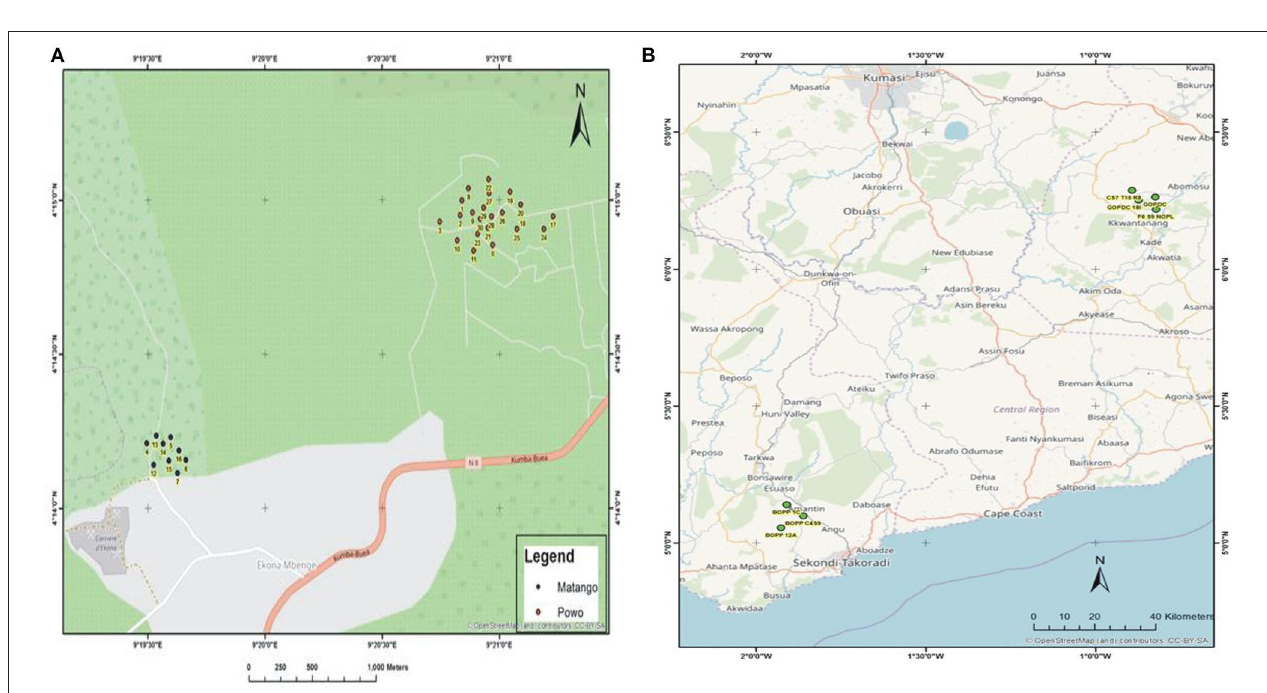
FIGURE 2 | (A) The GIS map site of sample collection in Cameroon . (B) The GIS map site of sample collection in Ghana.